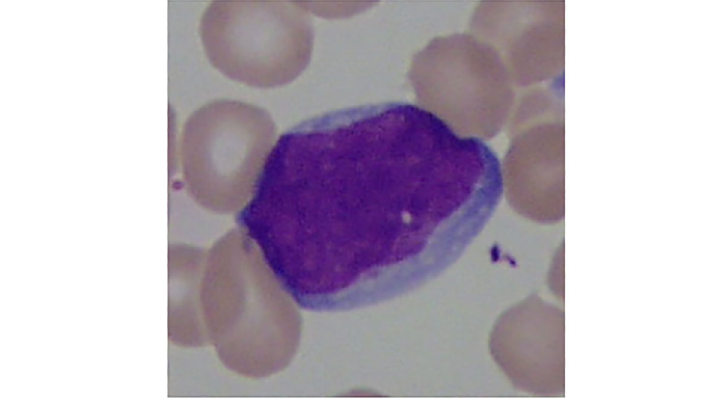
Figure 16. Sample ALL WBCs image being tested.